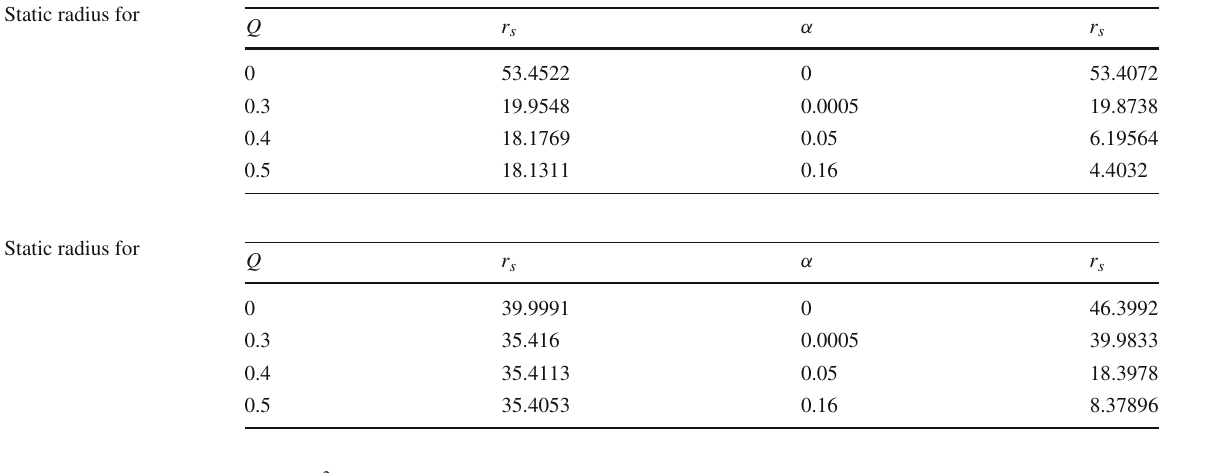
Table 7 Inner( r h − ) and outer ( r h + ) for ω = − 2